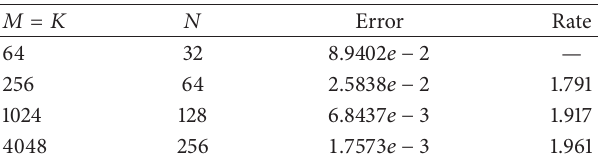
Table4:Comparisonsofournumericalsolutionswiththeanalytical